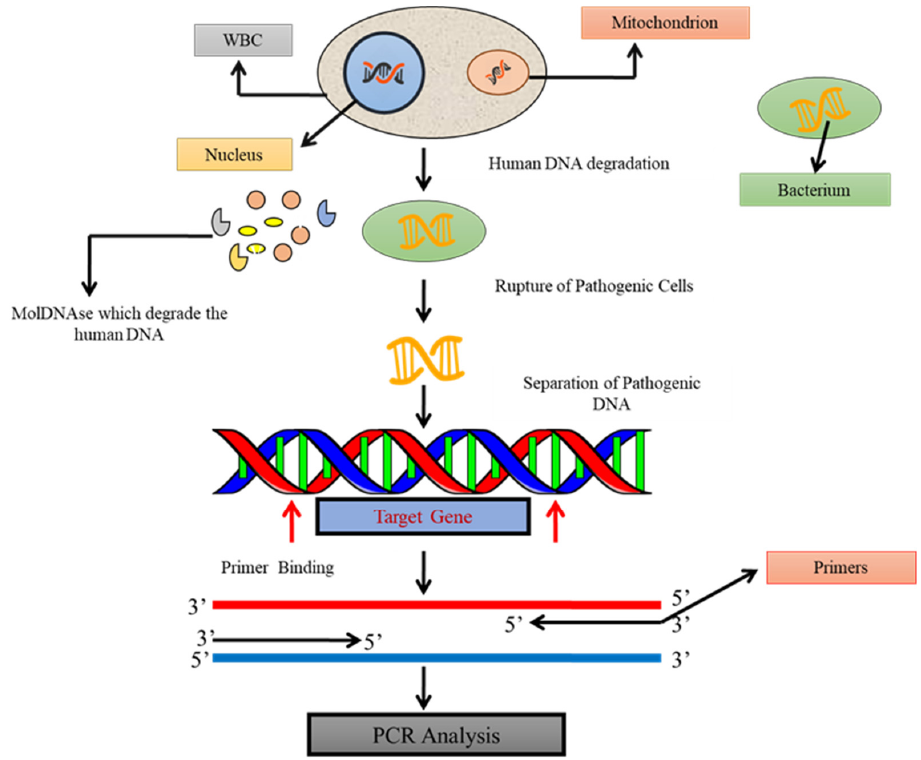
Figure 2. The principle of testing pathogenic DNA by standard PCR in blood samples. Schematic diagram showing the amplification of a segment of DNA, using PCR where the target gene of bacterial DNA is synthesized into two new strands of DNA.